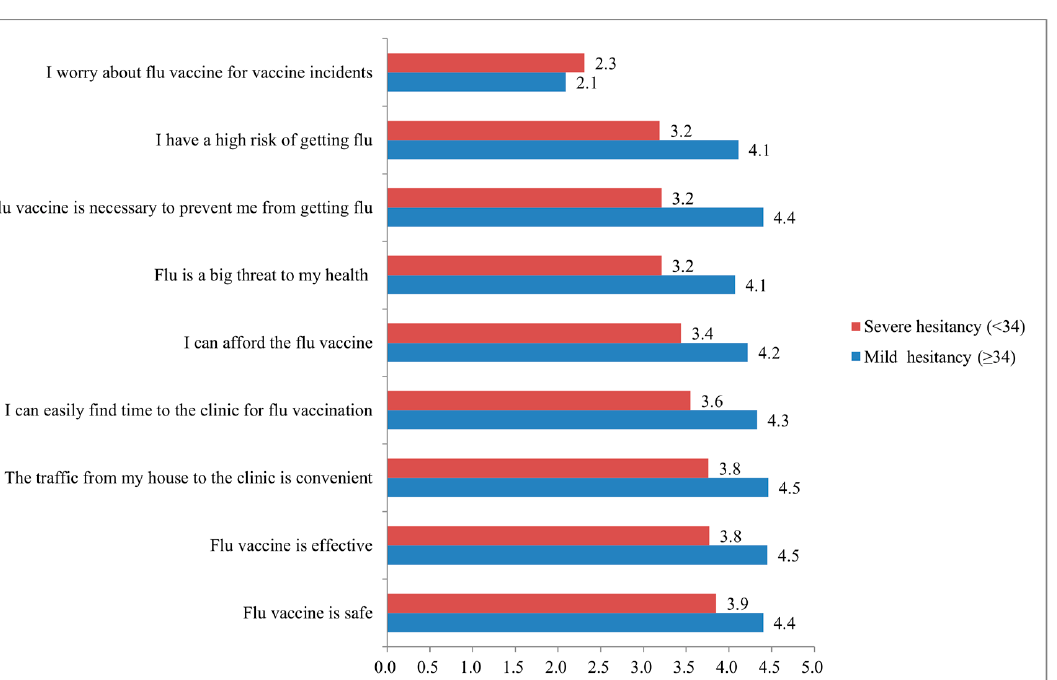
Table 4. Determinants of influenza vaccine hesitancy in community healthcare workers .